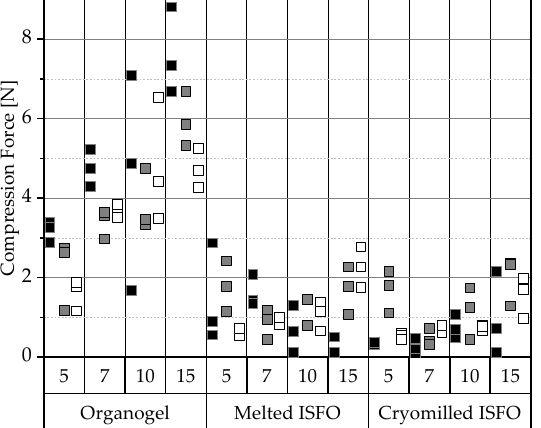
Figure 1. The compression force required to create a 1 mm indentation. The force required to indent the gel wafer by 1 mm was extracted from the force–displacement-curves. The data are categorized by the manufacturing process and 12-HSA concentration. The compositions of the gels are coded by the liquid lipid used (PO , MCT , IPM ).